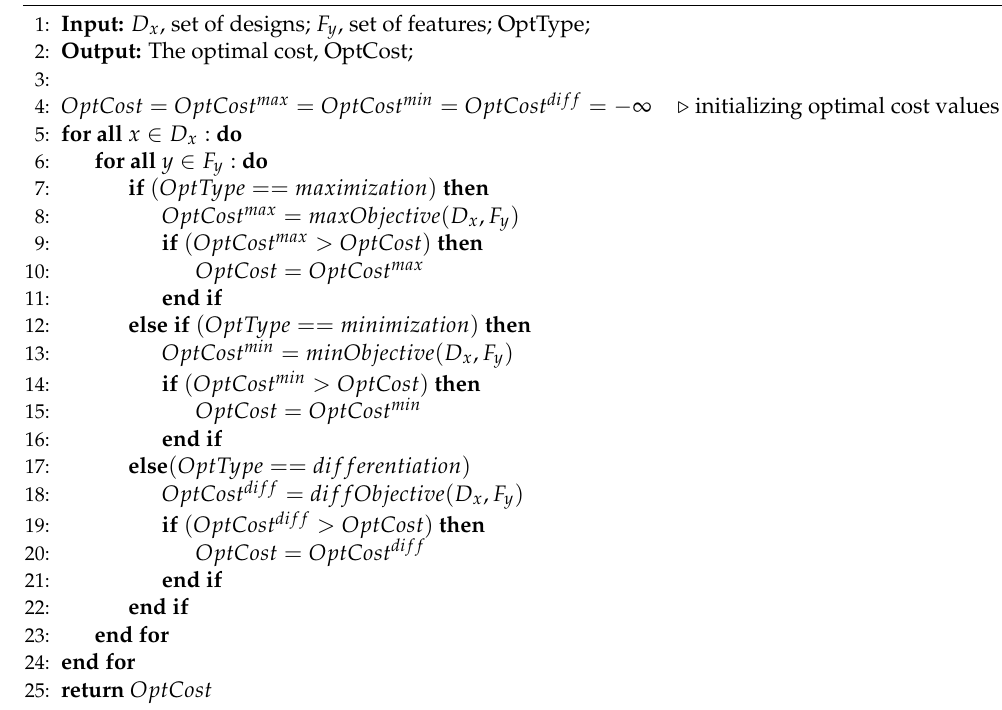
Algorithm 1 Optimal design cost